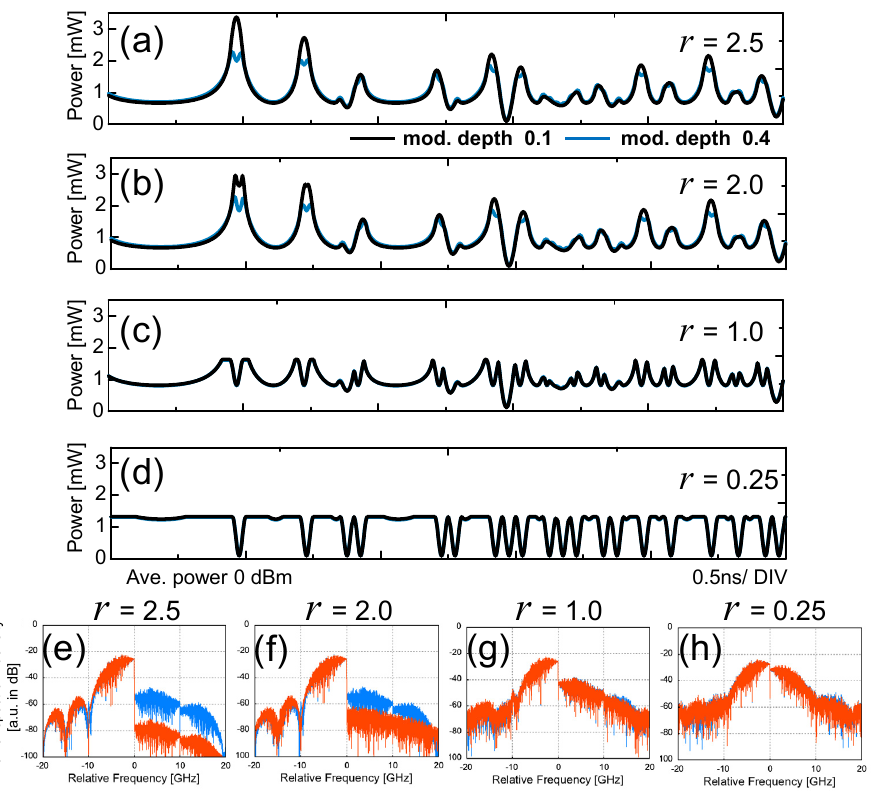
Figure 8. Peak-clipped OSSB-SC signal with variable clipping voltage, ( a – d ) modulator output intensity waveforms at r = 2.5, r = 2.0, r = 1.0, r = 0.25 respectively. ( e – h ) power spectra of the waveforms of ( a – d ) respectively.